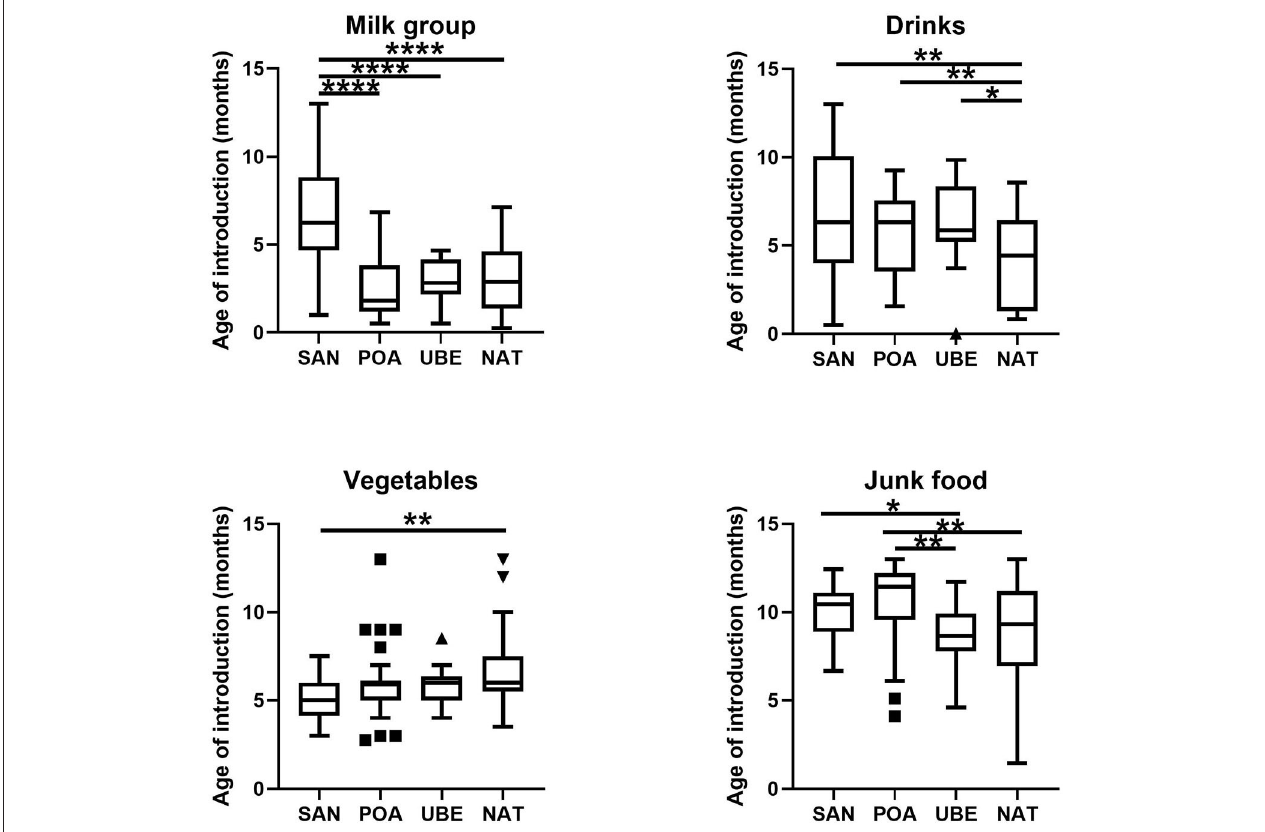
FIGURE 2 | Food groups based on 2-day food frequency questionnaire (FFQ) documented. Milk group includes cow’s milk, breastmilk (if any), formula, and yogurt; drinks include sweetened juices and beverages; vegetables are inclusive of legumes; junk food includes sweets, biscuits, and chocolate. Differences in frequencies of complementary foods consumption, such as food puree and family diet, were not shown, as they were not statistically significant. Where * p < 0.05, ** p < 0.005, **** p < 0.0001.